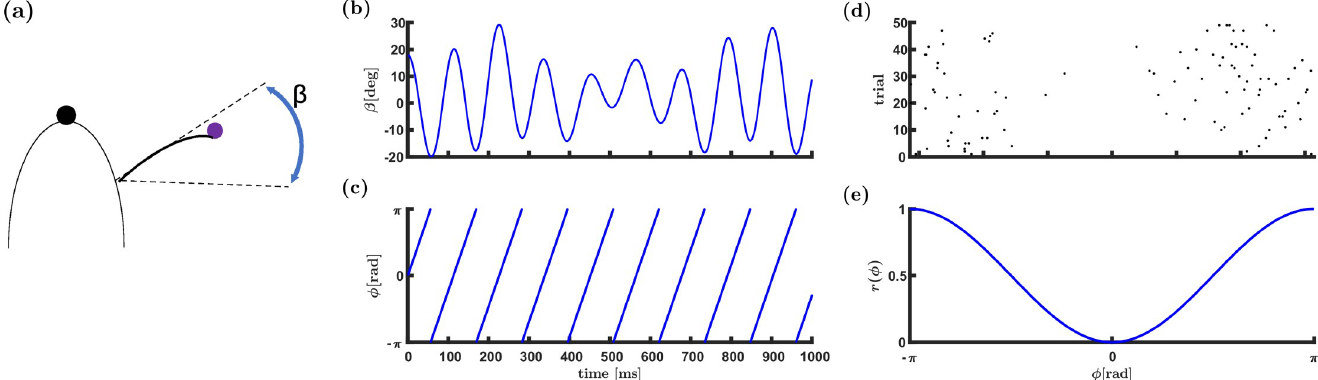
Fig 1. Representation of the whisking phase. (a) Mice and rats can infer the azimuthal location of an object by touch. (b) The angular position of a whisker, β , (during whisking) is shown as a function of time. The angle is often modeled as β ( t ) = β midpoint ( t ) + Δ β ( t ) cos( ϕ ( t )), where β midpoint ( t ) and Δ β ( t ) are the midpoint and the whisking amplitude, respectively. (c) The whisking phase ϕ as a function of time is ϕ ( t ) = ( νt ) mod2 plot and normalized tuning curve of a neuron with a preferred phase near maximal retraction.